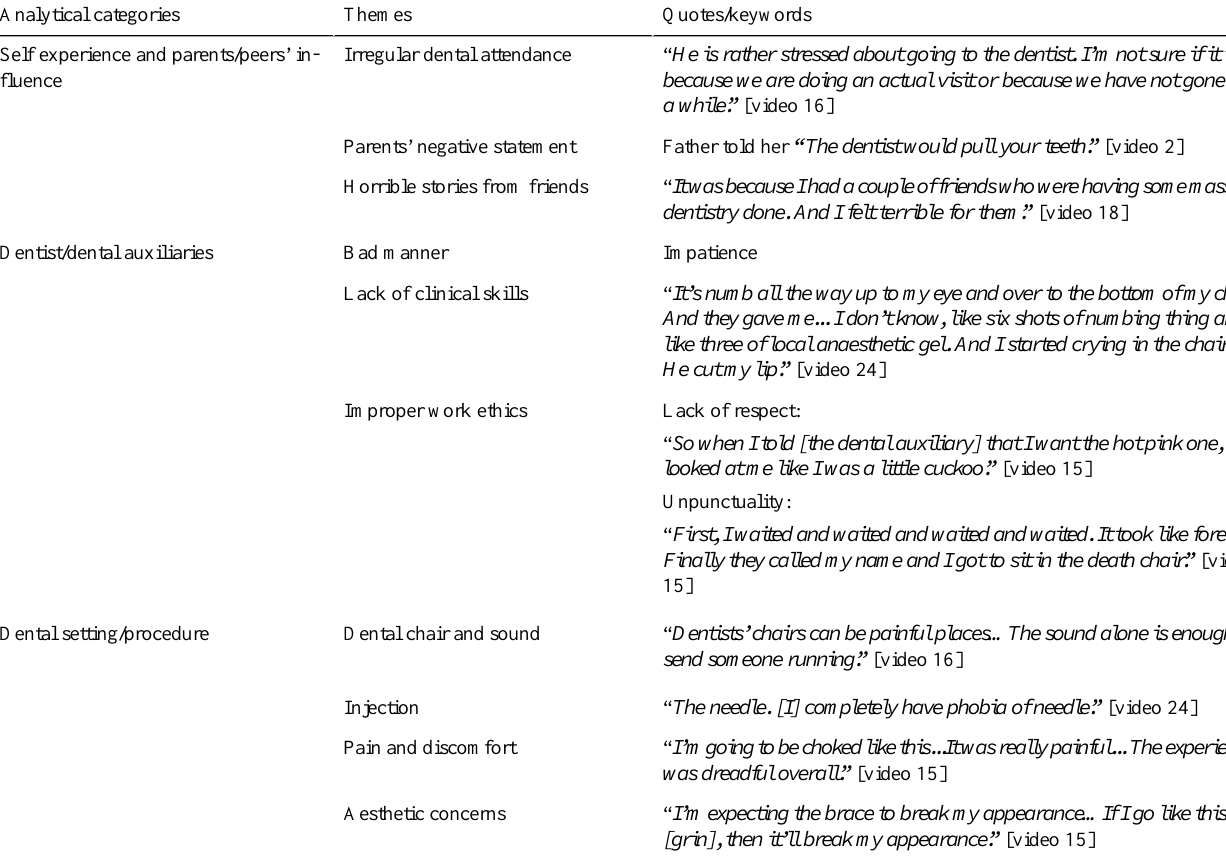
Table 3. Origins of DFA of children and